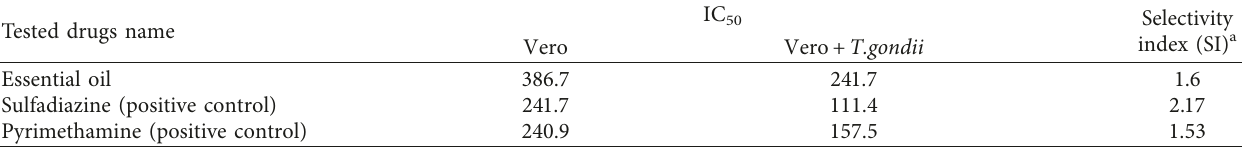
Table 2: In vitro activity and selectivity of essential oil, sulfadiazine and pyrimethamine against Toxoplasma .